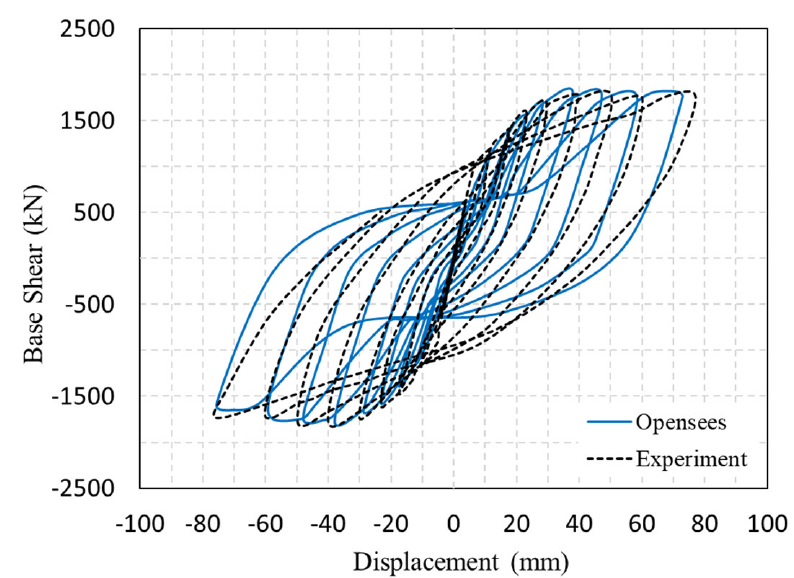
Figure 9. Hysteresis curves of the test specimen and OpenSees model.